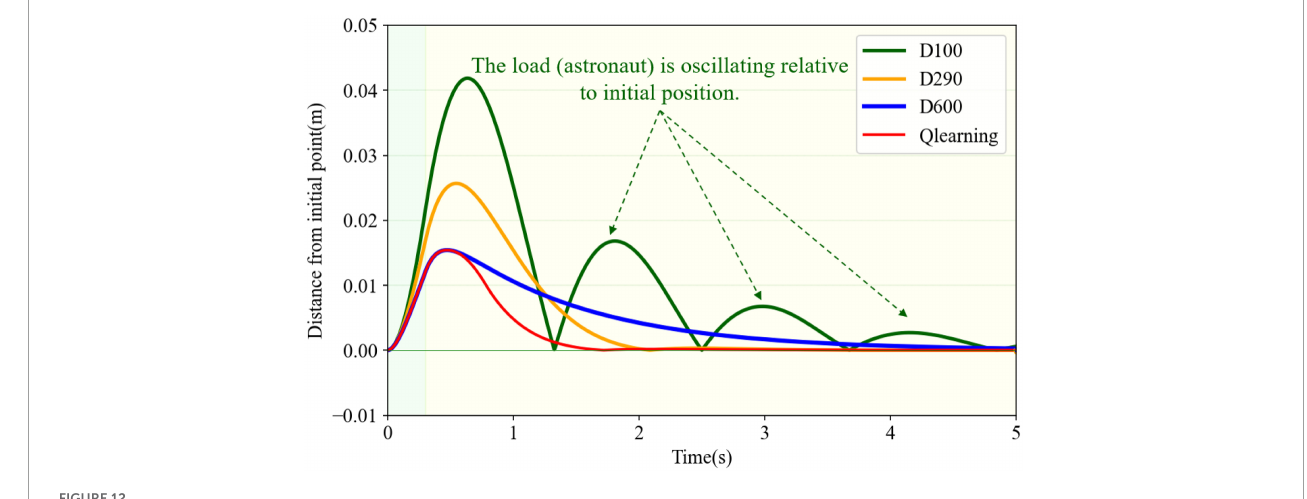
FIGURE12 Distance from the initial point in different damping cases.